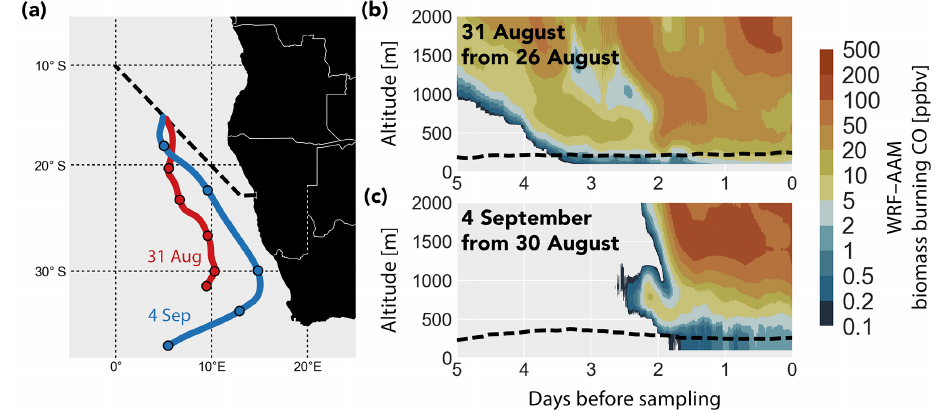
Figure 5. (a) Map of HYSPLIT MBL back trajectories for 31 August (red) and 4 September (blue). Circles are plotted every 24h after initialization. The ORACLES-2016 routine flight path is plotted as a dashed black line for reference. Curtains of WRF–AAM biomass- burning-tagged CO along the path of the trajectories are plotted in (b) for 31 August and (c) for 4 September, with the trajectory altitude indicated by the dashed black